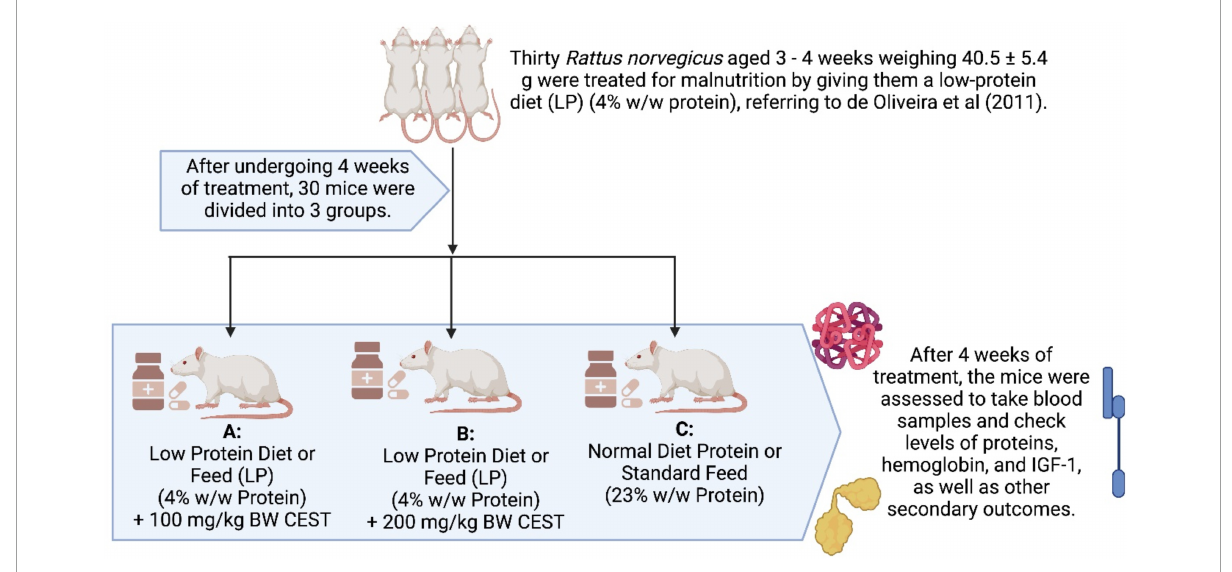
FIGURE1 Study design (malnourished rats). The figure was using a legal and licensed